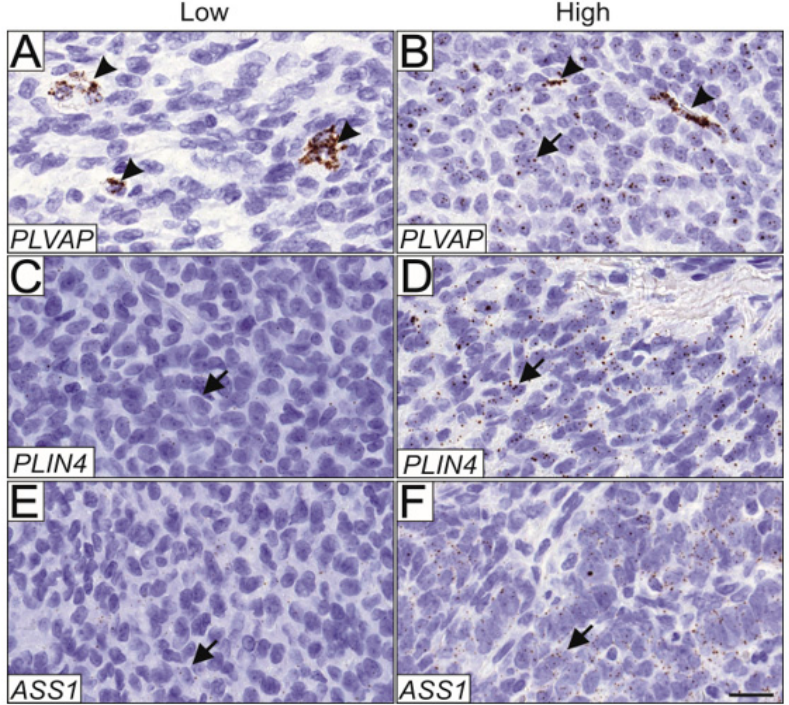
Figure 4. Validation of PLVAP, ASS1, and PLIN4 expression in AGCT tissue microarray. mRNA expression patterns of PLVAP, ASS1, and PLIN4 were assessed in a cohort of 175 AGCT samples using RNA in situ hybridization. Representative images of low and high expression patterns are shown. PLVAP was expressed in 33.8% of samples only in the endothelial cells ( A ), and both in endothelial and AGCT cells in 25.5% of the samples ( B ). Representative images of low and high ASS1 expression ( C , D , respectively), and low and high PLIN4 expression ( E , F , respectively) in AGCT cells. Magnification 164.5×, and scalebar 20 µm. Arrowheads indicate positively stained endothelial cells and arrows indicate positively stained AGCT cells.